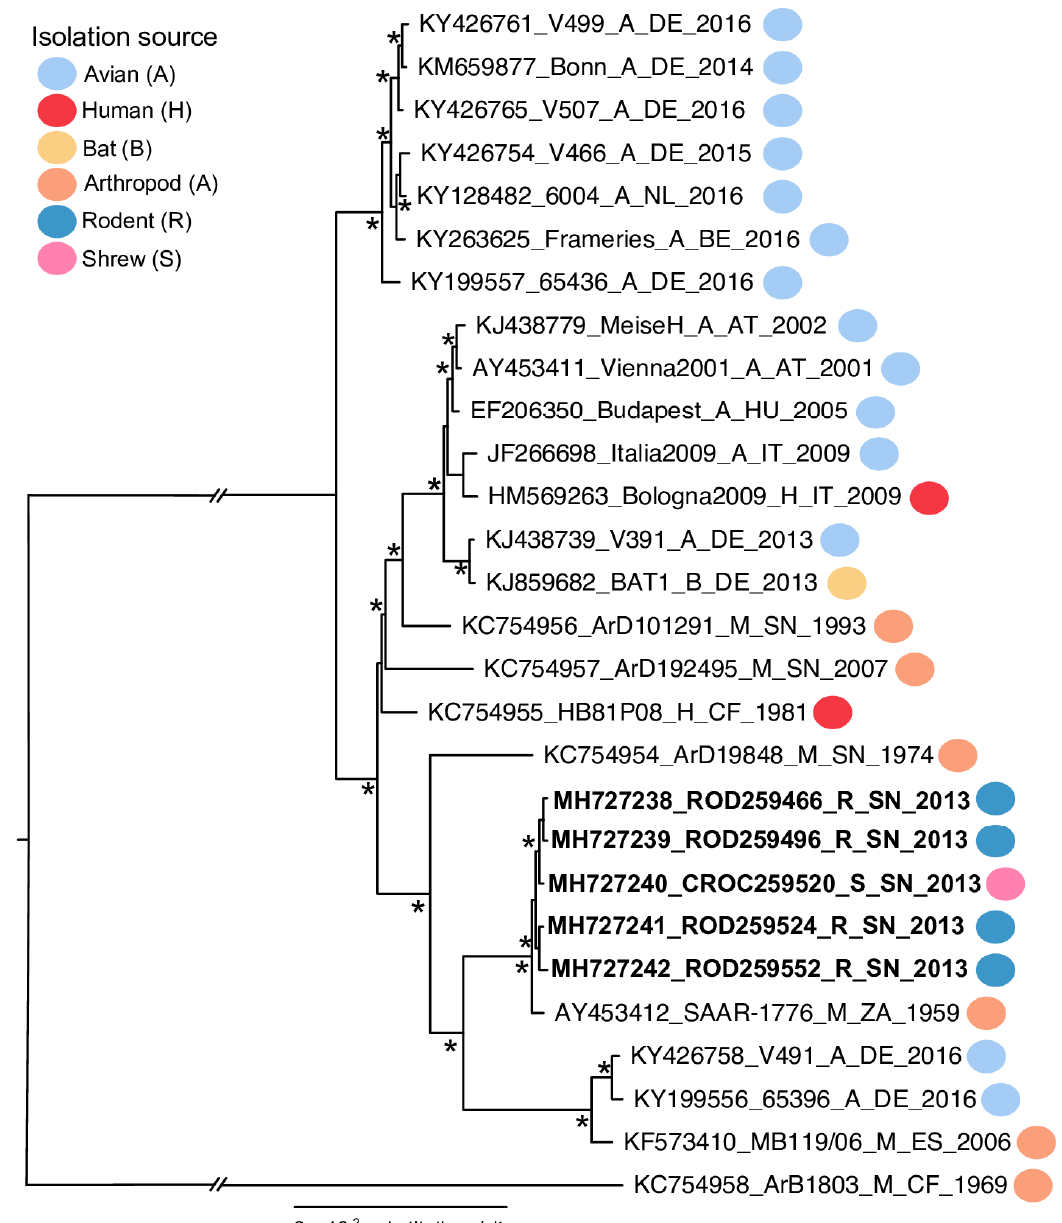
Figure 3. A maximum-likelihood phylogenetic tree estimated using 28 USUV polyprotein sequences. Rodent taxon labels are in bold. The colored circles indicate the host where the USUV sequence originated. The asterisks (*) at major nodes indicate an SH-like support value > 70%. The tree branches are scaled by the nucleotide substitutions per site.